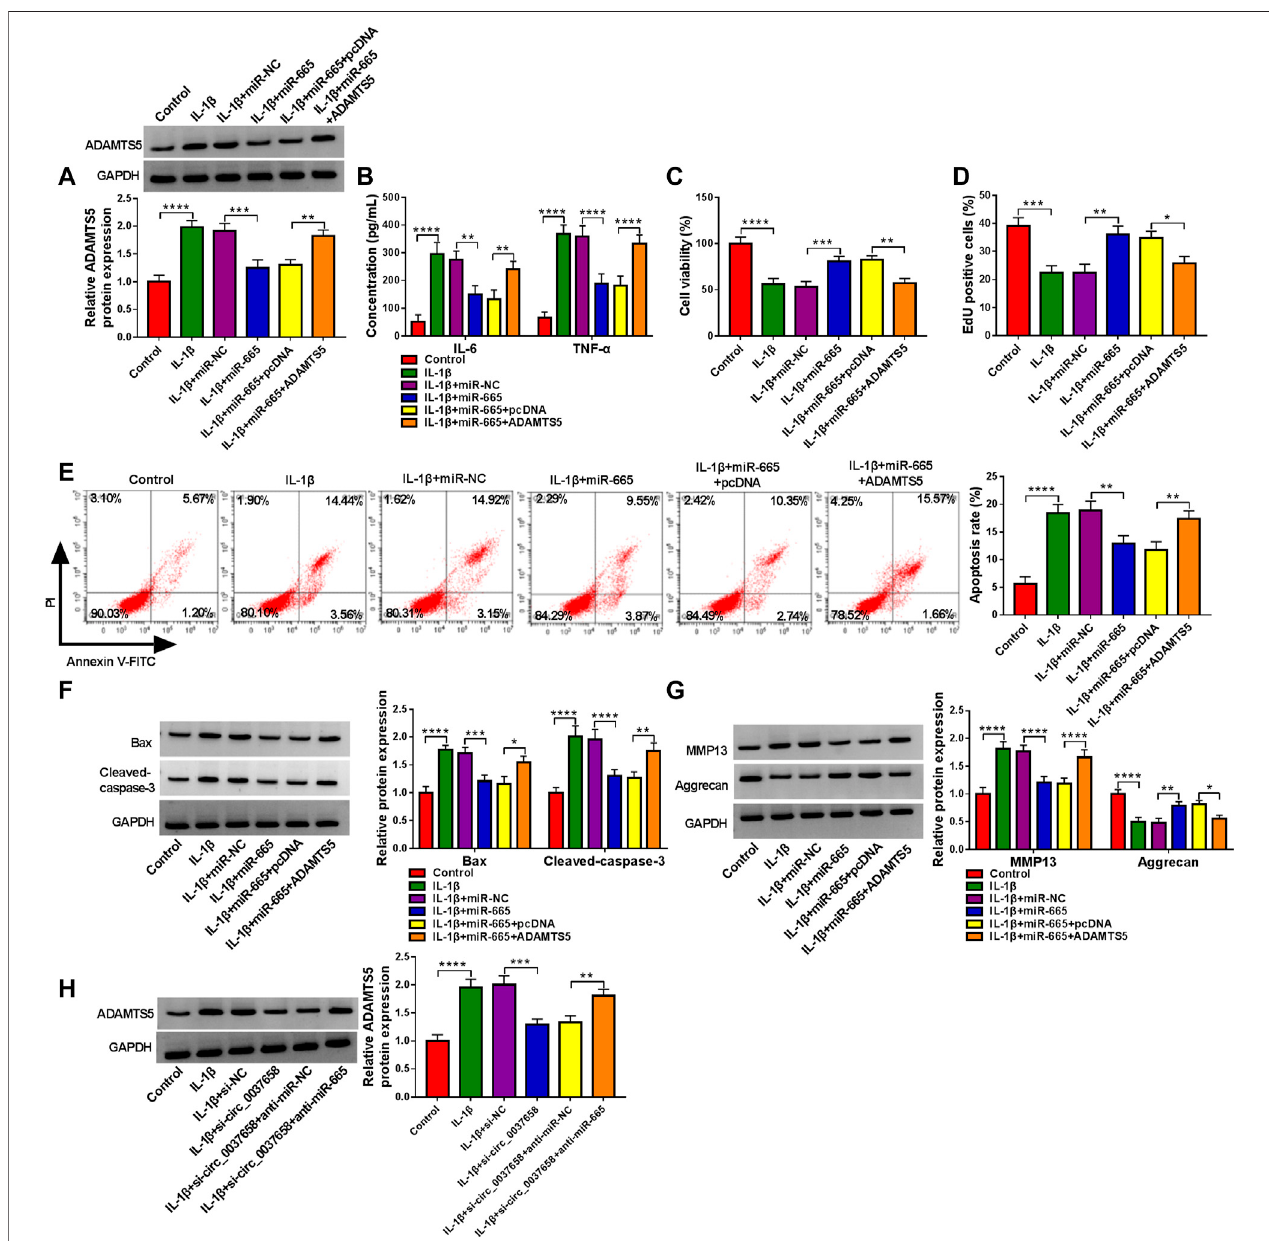
FIGURE6| miR-665-mediated in fl ammation, proliferation,apoptosis,and ECMdegradation wasabolishedbyinteractingwith ADAMTS5. (A – G) CHON-001 cells were treated with IL-1 β , IL-1 β + miR-NC, IL-1 β +miR-665, IL-1 β +miR-665 + pcDNA, IL-1 β +miR-665 + ADAMTS5, or without (Control). (A) ADAMTS5 protein level was determinedintreatedCHON-001cellsusingwesternblotassay. (B) IL-6andTNF- α levelsintreatedCHON-001cellswereexaminedbyELISAkit. (C,D) CHON-001cell proliferative ability was measured by CCK-8 assay and EdU assay. (E) CHON-001 cell apoptosis rate was monitored by fl ow cytometry assay. (F,G) Protein levels of Bax, Cleaved-caspase-3, MMP13, and Aggrecan were determined by western blot assay. (H) ADAMTS5 protein level was detected in CHON-001 cells were treated withControl,IL-1 β ,IL-1 β +si-NC,IL-1 β +si-circ_0037658,IL-1 β +si-circ_0037658+anti-miR-NC,andIL-1 β +si-circ_0037658+anti-miR-665bywesternblotassay.****or ***indicates p < 0.0001or p < 0.001whenIL-1 β groupwascomparedtothenegativecontrolgroupand**,***,or****indicates p < 0.01, p < 0.001or p < 0.0001whenIL- 1 β +miR-665 group was compared to the IL-1 β + miR-NC group and *, **, or **** indicates p < 0.05, p < 0.01, or p < 0.0001 when IL-1 β +miR-665 + ADAMTS5 was compared to IL-1 β +miR-665 + pcDNA. These results were presented as the mean ± (SD), n = 3.